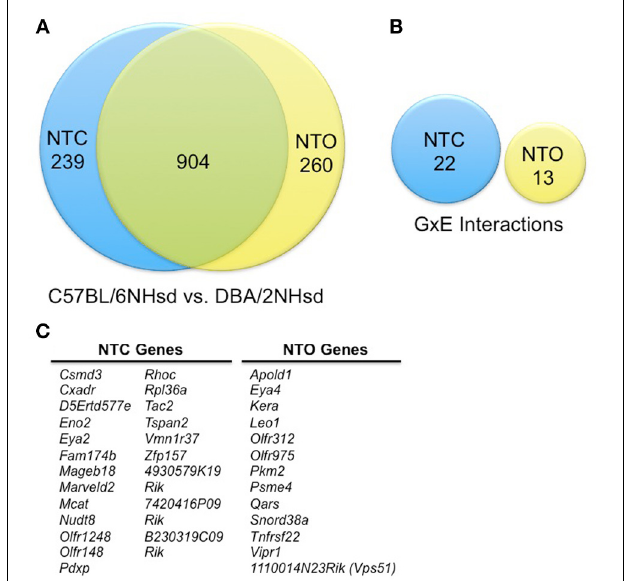
FIGURE 1 | Summary of the differentially expressed genes. (A) Line-specific differences in gene expression. We conducted this analysis in two separate experiments that captured two embryonic phenotypes: neural tube closed (NTC) and neural tube open (NTO). This analysis was conducted by examining the gene expression changes solely between C57BL/6NHsd and DBA/2NHsd; alcohol exposure is not taken into consideration. Therefore, in the NTC group, all C57BL/6NHsd embryos (with and without alcohol) were measured as one cohort, while the DBA/2NHsd embryos (with and without alcohol) comprised the second group. The NTO cohort was analyzed in the same manner. This depicts the innate changes in gene expression between the two genetic backgrounds, plus the changes that are due to alcohol exposure, but cannot assess if there are interactions between the genetic background and alcohol exposure. There are 1403 genes that are differentially expressed between the C57BL/6NHsd and DBA/2NHsd embryos; 904 of these are differentially expressed in both the NTO and NTC studies. (B) Differential gene expression as result of genetic and alcohol interactions (GxE). As above, we analyzed gene expression in the NTC and NTO cohorts separately. In this study, we measured the potential interactions between alcohol exposure and genetic background. We found 22 genes that demonstrated GxE interactions in the NTC group and 13 genes showing GxE interactions in the NTO group. (C) Genes subject to GxE Interactions. The genes subject to GxE interactions are